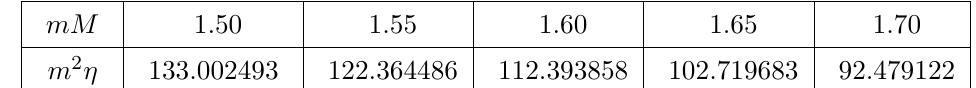
Table 1 . The coupling parameter m 2 (cid:17) with mr s = 3 : 5 and various mM .